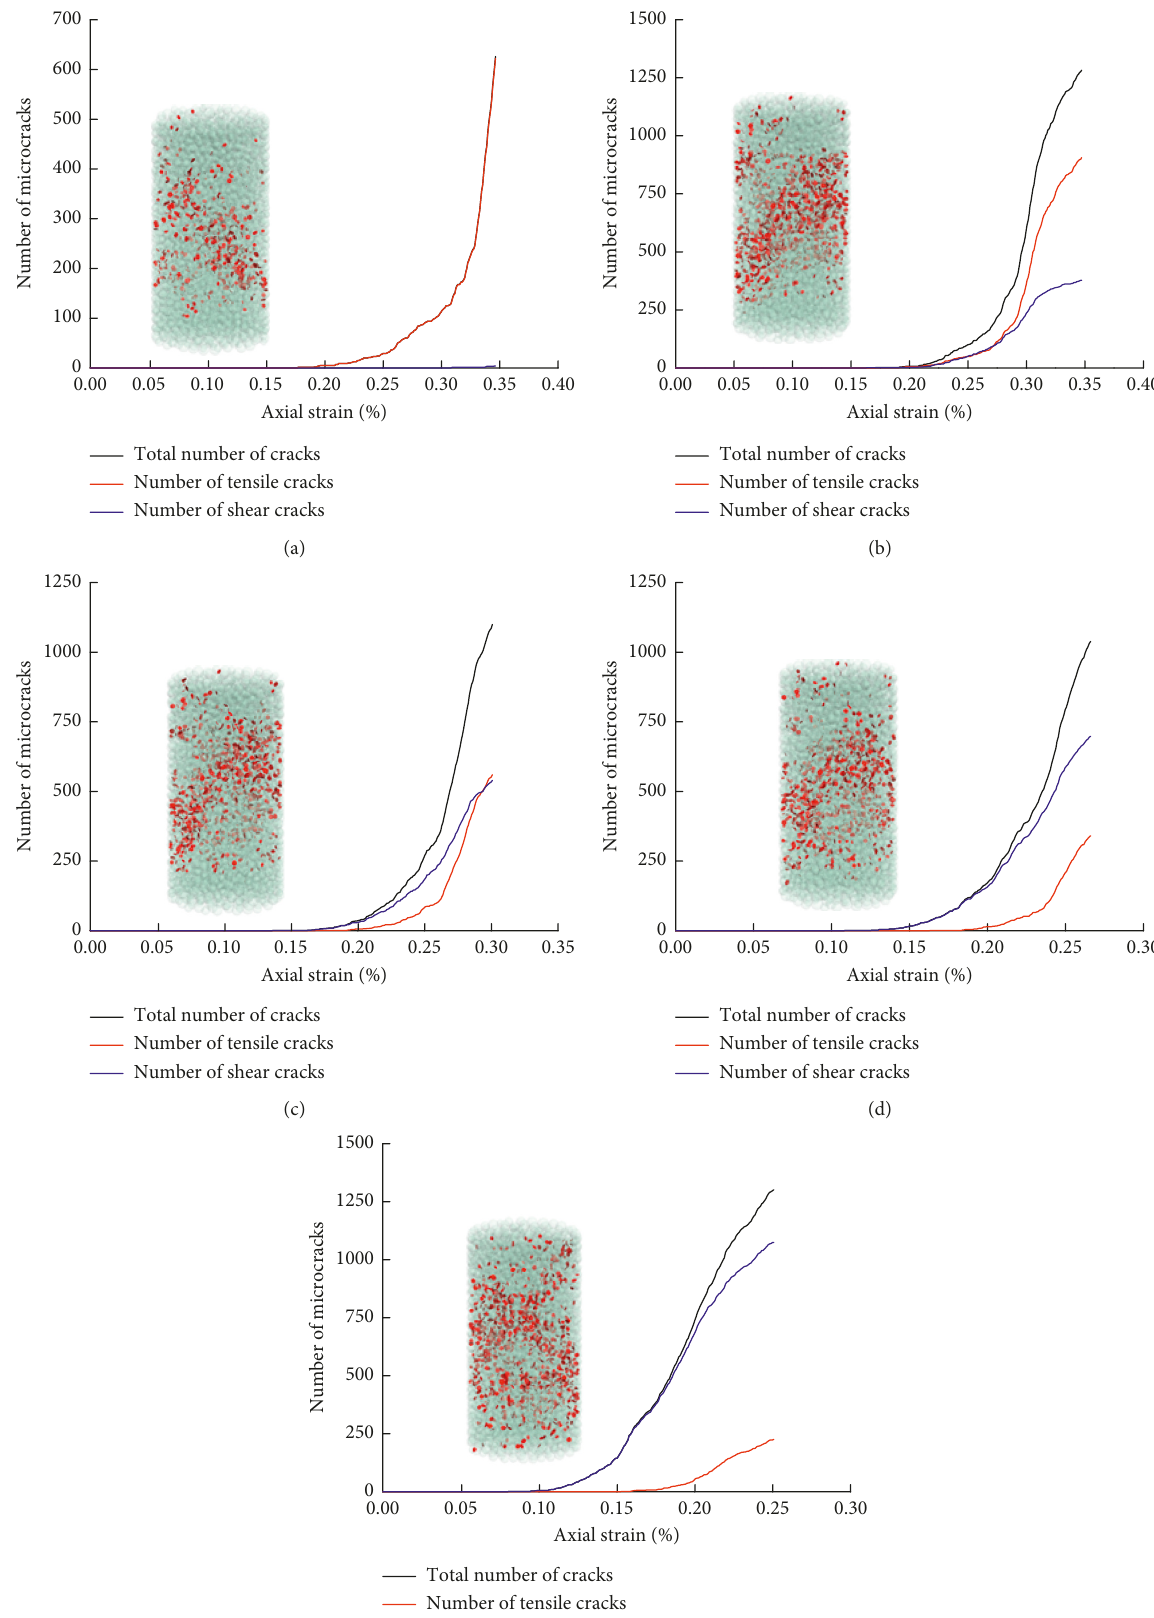
Figure 12: Microcrack number developments and failure pattern under different values of σ